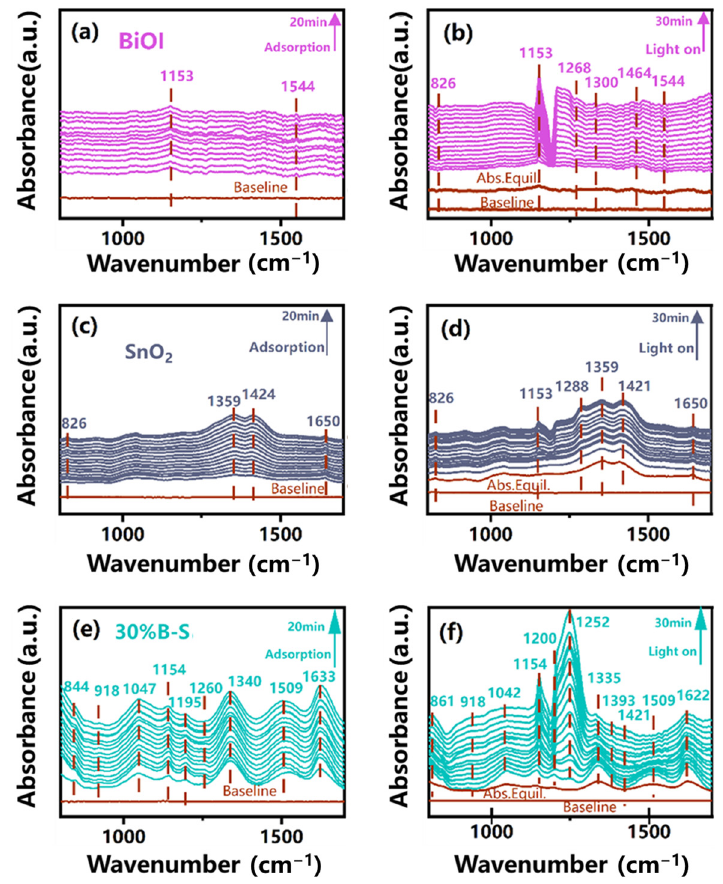
Figure 8. In situ DRIFTS spectra of NO adsorption and visible-light reaction processes over ( a , b ) BiOI, ( c , d ) SnO 2 , and ( e , f ) 30%B-S.